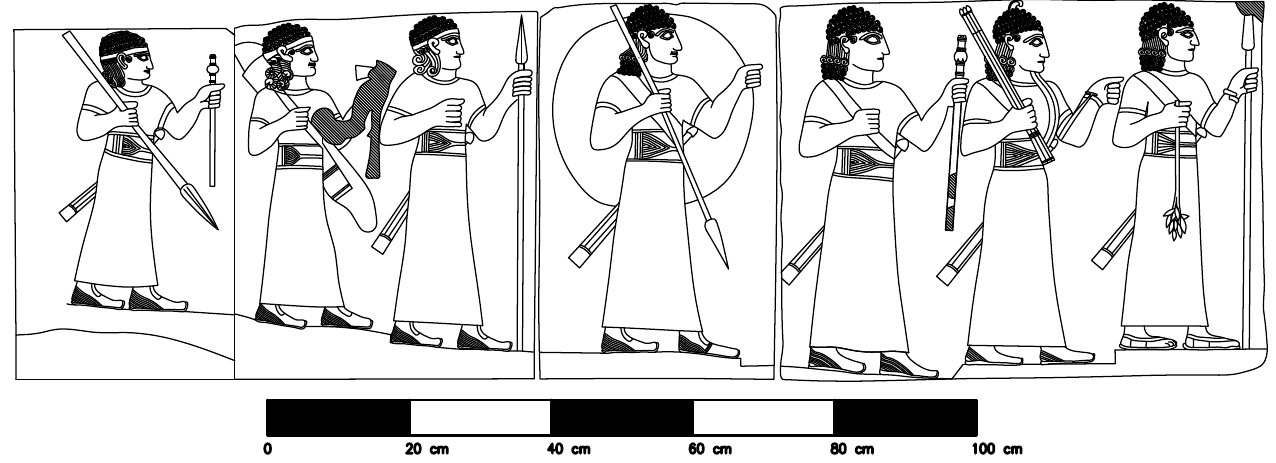
Figure 7. Royal Buttress, slabs B4–5: the “eunuchs’ line” (drawing by Elia